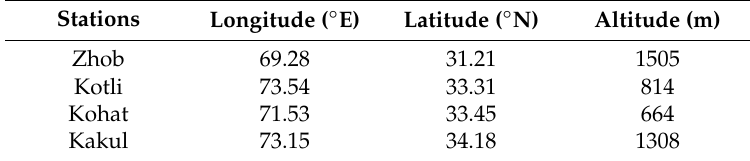
Figure 9. Elevation-dependent trend of temperature indices and precipitation for stations under the study region located at elevations above 500 m a.s.l. (black dash linear fit), and for additional stations (red linear fit) covering continuous elevation range of 500–2167 m. a.s.l, during the period 1967–2017. Table 4. Information of additional meteorological stations for elevation-dependent trend